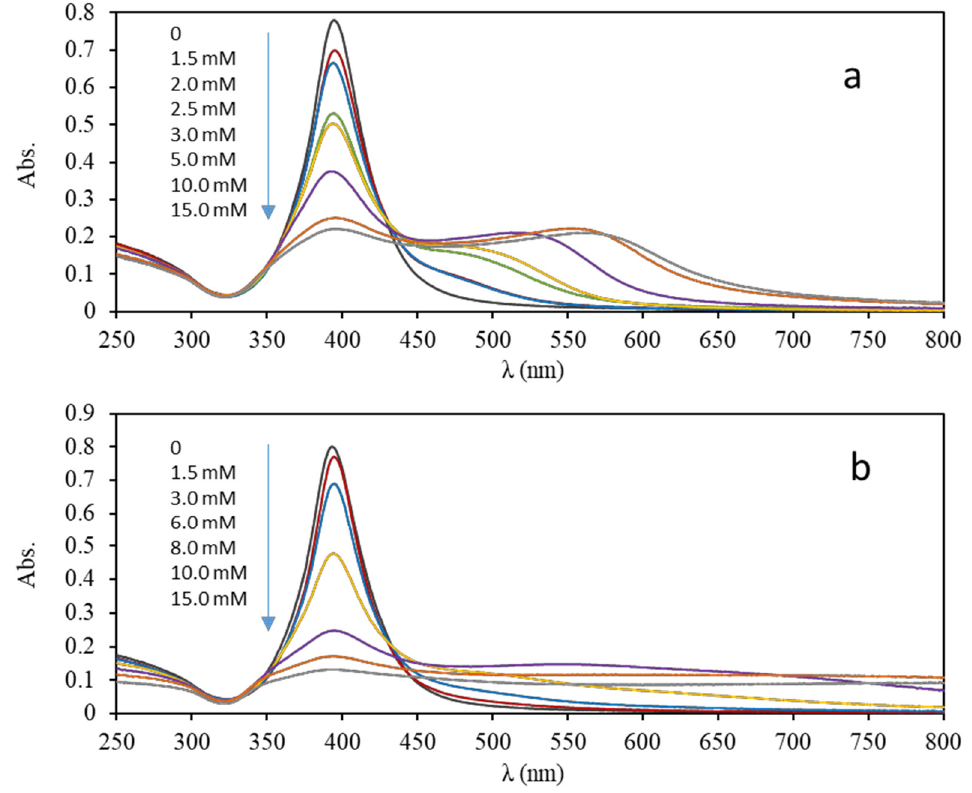
Figure 9. UV-Vis spectra recorded after 10 min. corresponding to the suspension of AgNPs in a 1: 4 dilution (5 µg/mL) in the presence of different concentrations of acetic acid ( a ) and hydrochloric acid ( b ).